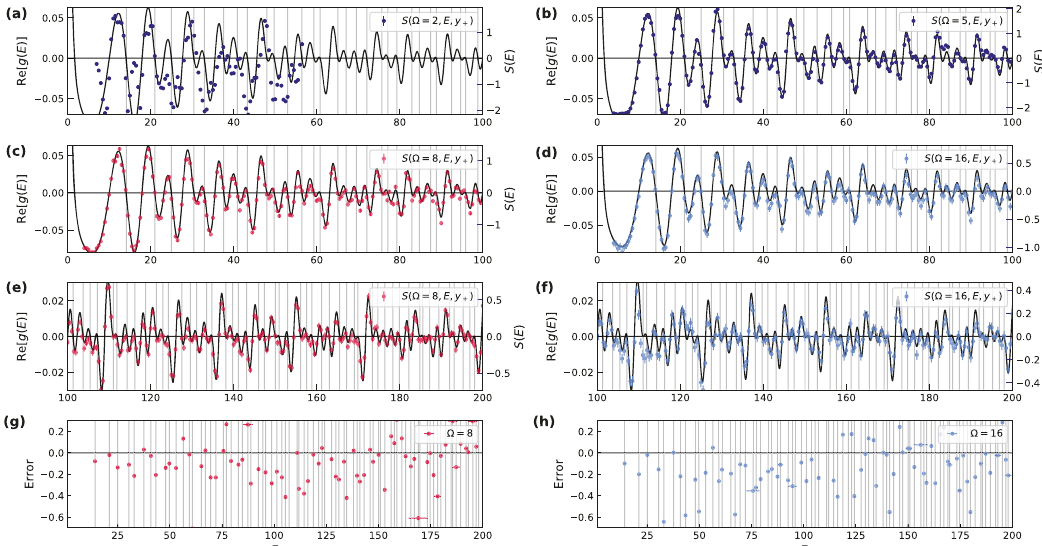
Fig. 2 Identifying Riemann zeros by observing the frozen dynamics of the state. In ( a – f ) the black curve is the real part of g ( E ). The vertical gray lines indicate the Riemann zeros, {14.1347, 21.022, 25.0109, 30.4249, 32.9351, ...}; the other points where g ( E ) crosses the axis correspond to Re ½ g ð E Þ(cid:3) vanishing but not Im ½ g ð E Þ(cid:3) , and so do not represent Riemann zeros. The dots are the S parameter which is de fi ned as S ( Ω , E , y + ) = ∑ n [ P ( n , Ω , E ) − 1/2], where n = {5, 10, 15, 20, 25, 30}. S ( Ω , E , y + ) is used to identify the Riemann zeros by observing S = 0. a When Ω = 2, the high-frequency limit is not well satis fi ed, so the behavior of S ( Ω , E , y + ) does not match g ( E ). b By contrast, Ω = 5 does give good agreement for E ≤ 100. c Increasing Ω further to 8 provides even better agreement with g ( E ). e We implemented the measurement for E up to 200 and identi fi ed the fi rst 80 Riemann zeros with high accuracy. d , f Results of Ω = 16. Data points with E ≤ 100 ( E ≥ 100) were obtained by 2000 (5000) measurements. The error bar δ S of S ( Ω , E , y + ) is the sum of the statistical errors of the corresponding P ( n , Ω , E ), where n = {5, 10, 15, 20, 25, 30}, within one standard deviation. g , h Zeros were extracted by interpolating S ( Ω , E , y + ) using a cubic polynomial 4000 times. Each time, S is sampled randomly in [ S − δ S , S + δ S ]. The error (dot) is the difference between the extracted zeros and the exact zeros (see Supplementary Information), with the error bars indicating the standard deviations of the extracted zeros. A vertical line with no red dot has an error falling outside the plot range.